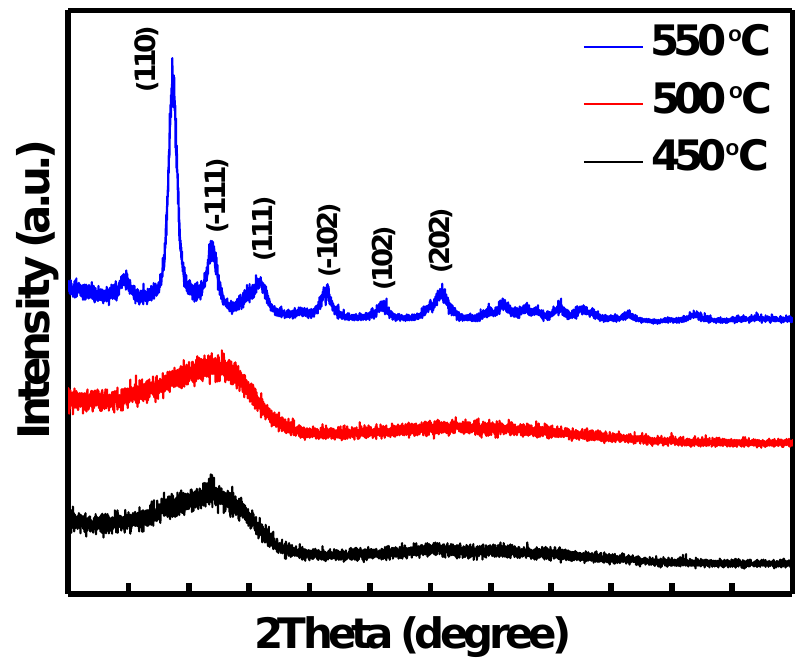
Figure 2. GIXRD patterns of the HfO 2 films with various temperatures.